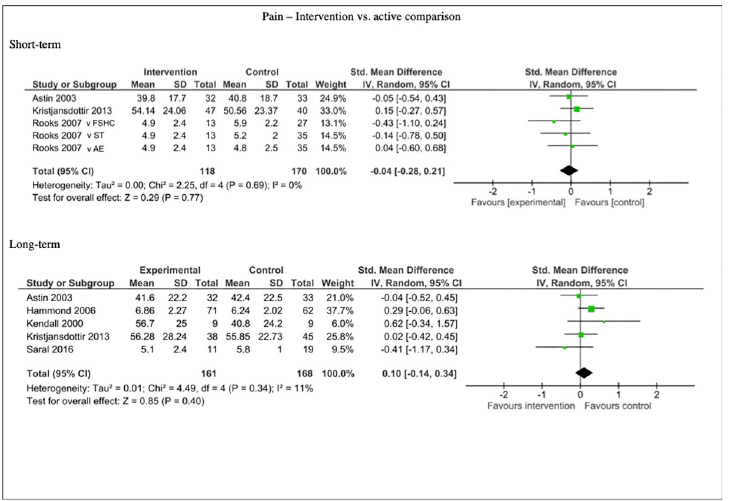
Fig 11. Forest plots of comparisons for self-reported pain measures for intervention compared to active